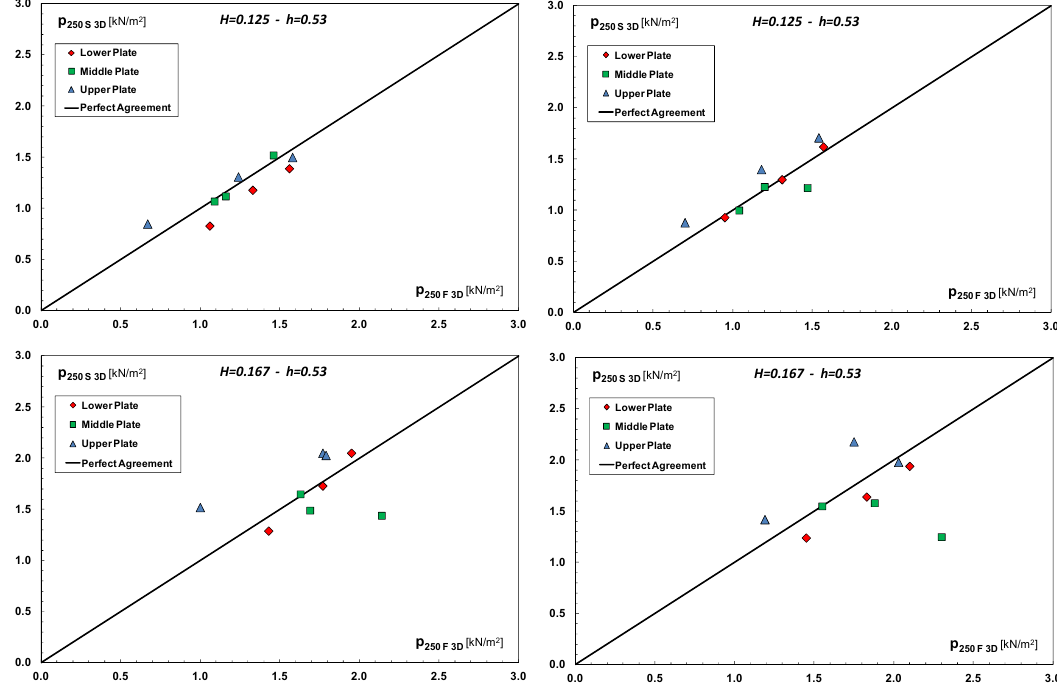
= 0.125 m, T = 1.55 s, n = 10. Low left: s p = 0.167 m, T = 1.81 s, n = 10. s p